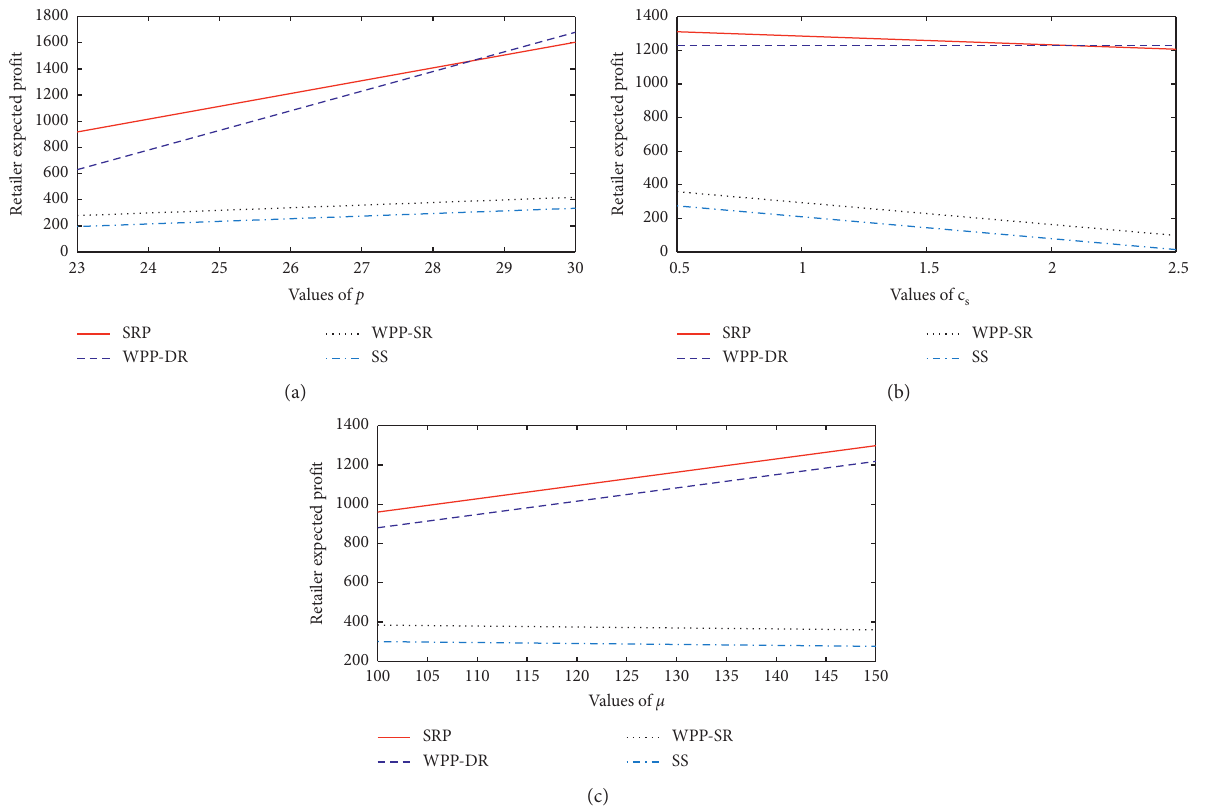
Figure 2: The retailer’s expected profit under different values of p , c